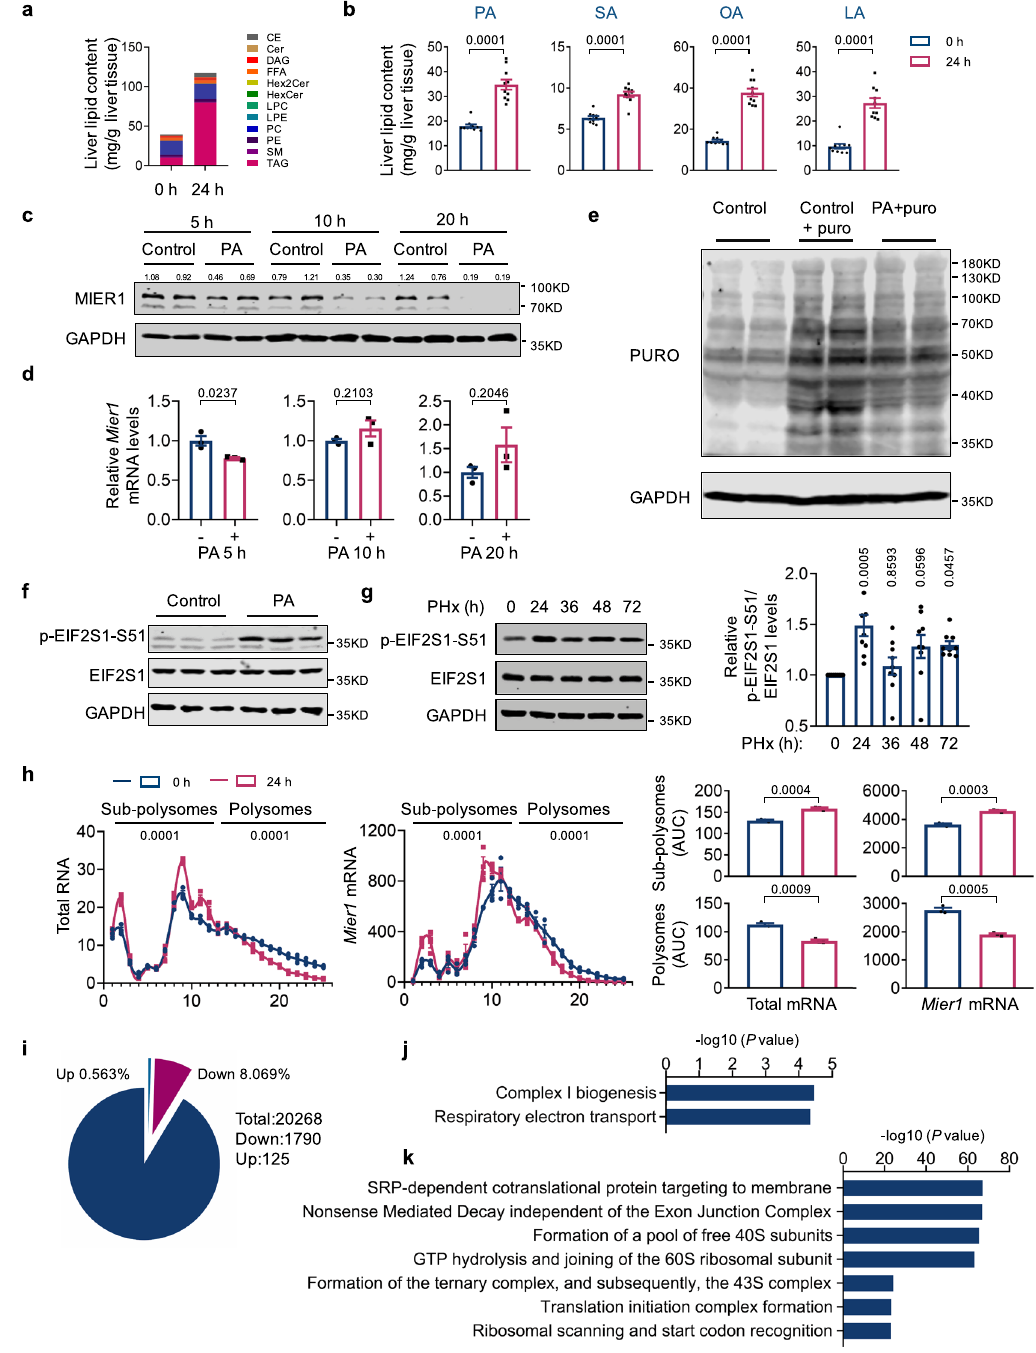
Fig. 4 | Acute hepatic lipid accumulation regulates MIER1 expression via acute stress-inducedtranslationalcontrol. Quanti fi cationofdifferentlipidspecies( a ) and major fatty acids in lipid composition ( b ) in liver tissues from NCD animals at 0h and 24h after PHx. n =10. Immunoblots (MIER1 and GAPDH) ( c ) and relative Mier1 mRNA level ( d ) in primary hepatocytes after treatment with pal- mitic acid (PA, 0.5mM) for indicated times. n =3. Protein synthesis analysis ( e ) and immunoblots of EIF2S1 phosphorylation ( f ) in primary hepatocytes treated with or without PA for 10h. Images show detection of puromycylated nascent proteins ( e ). g Immunoblots of liver EIF2S1 phosphorylation before or after hepatectomy. P values are between each group with group “ 0h ” . n =3. h Polysome pro fi les and qRT-PCR analysis of distributions of indicated